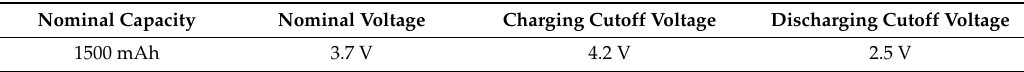
Figure 1 . Experiment platform. Figure 1. Experiment platform. Table 1. Main specifications of the tested Table 1 . Main specifications of the tested battery .